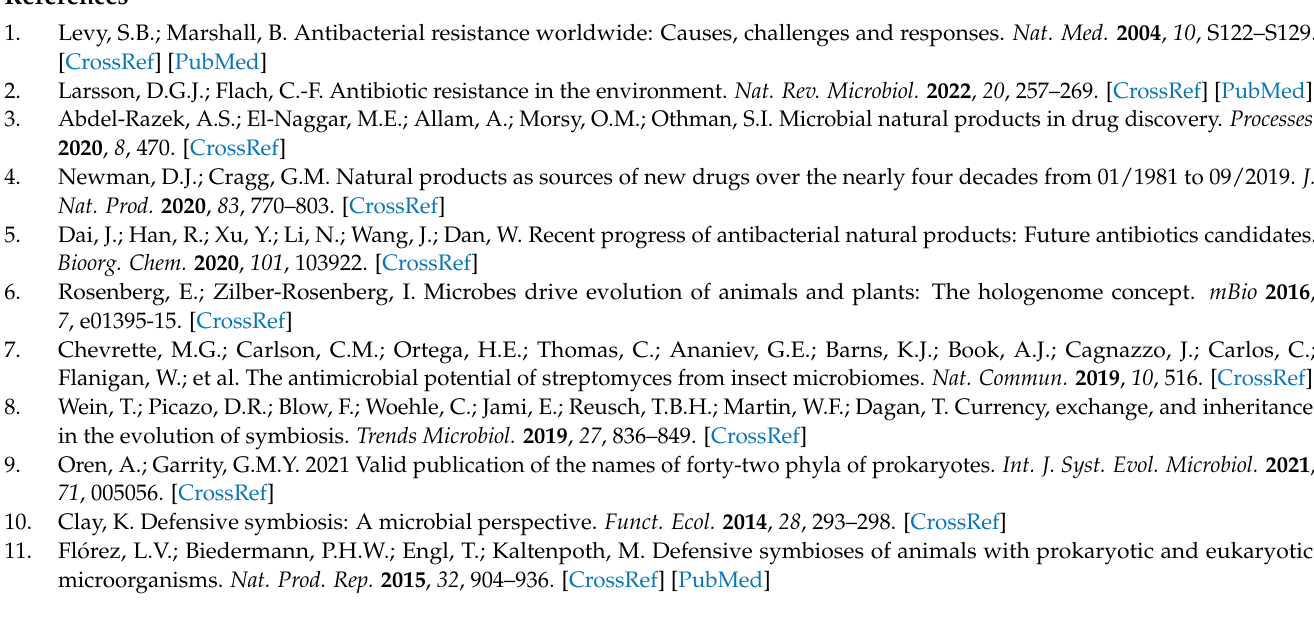
Table S5: Antimicrobial activity of Streptomyces globisporus subsp. globisporus 4-3, isolated from Messor structor